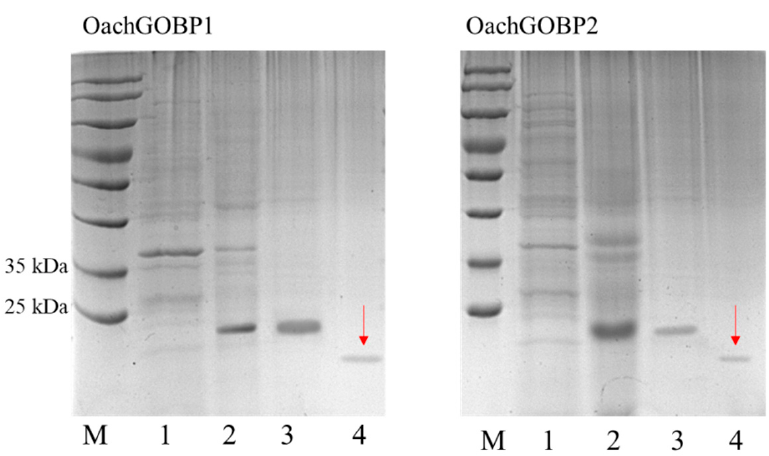
Figure 3. 15% SDS-PAGE analysis of recombinant pET 30a(+)/OachGOBPs protein. M: Protein molecular mass marker; 1: supernatant; 2: inclusion bodies; 3: recombinant pET 30a(+)/OachGOBPs protein after purification with Ni-NTA; 4: target proteins without His-tag (indicated by red